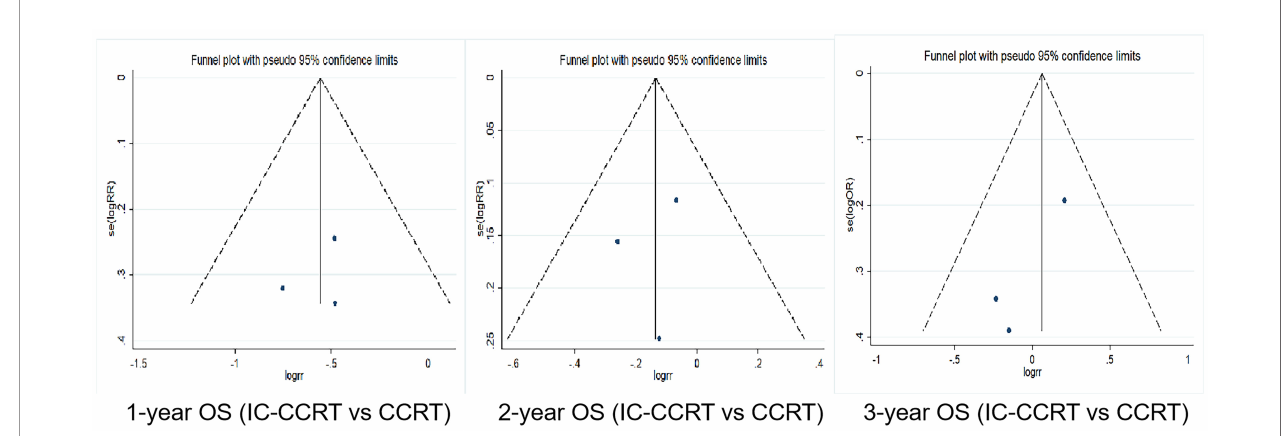
FIGURE 5 | Funnel plots for 1-, 2-, and 3-year OS rate between IC-CCRT group and CCRT alone group. OS, overall survival; IC-CCRT, induction chemotherapy followed by concurrent chemoradiotherapy; CCRT, concurrent chemoradiotherapy; CCRT,